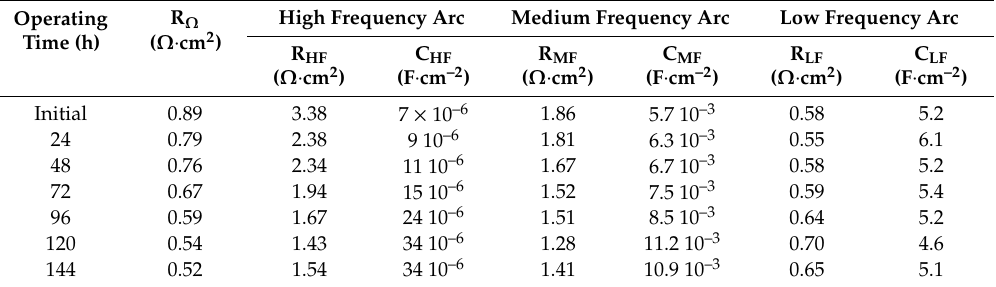
Table 1. Resistance and capacitance values obtained from the impedance data fitting shown in Figure 2c to equivalent circuit under wet CH 4 (3% H 2 O) for di ff erent operating times at 850 ◦